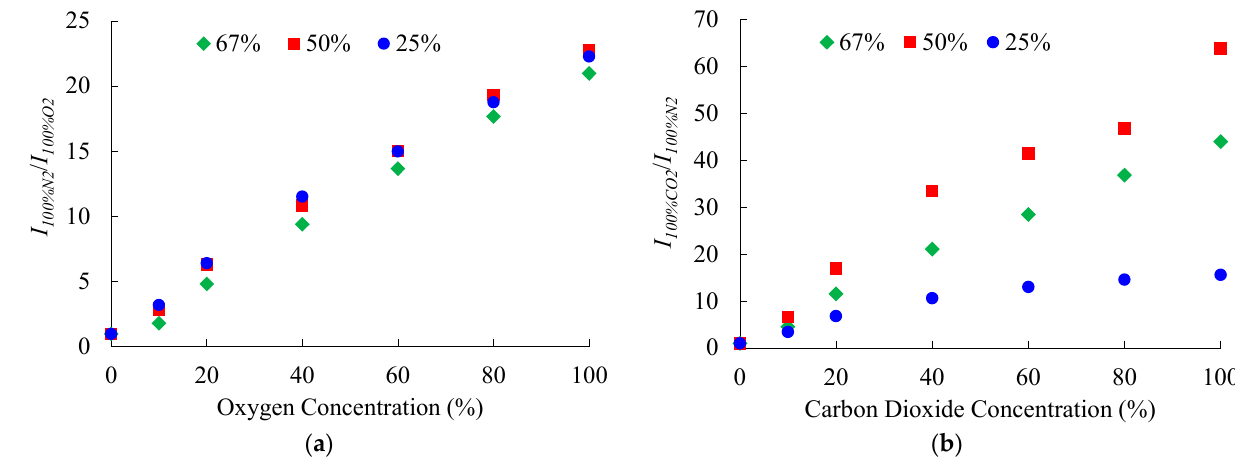
Figure 10. Effect of humidity on the sensitivities of ( a ) O 2 and ( b ) CO 2 of the optical dual sensor. Previous studies have reported that gas sensors are extremely sensitive to temperature changes. In this section, the effect of temperature changes on the sensitivities of the dual sensor is examined. Figure 11 shows the relationship between sensitivities of O 2 and CO 2 at different elevated temperatures. With the increase in the working temperature from 22 to 60 ◦ C, the sensitivity of O 2 does not exhibit a significant change, whereas the CO 2 sensitivity decreases from 58 to 5.